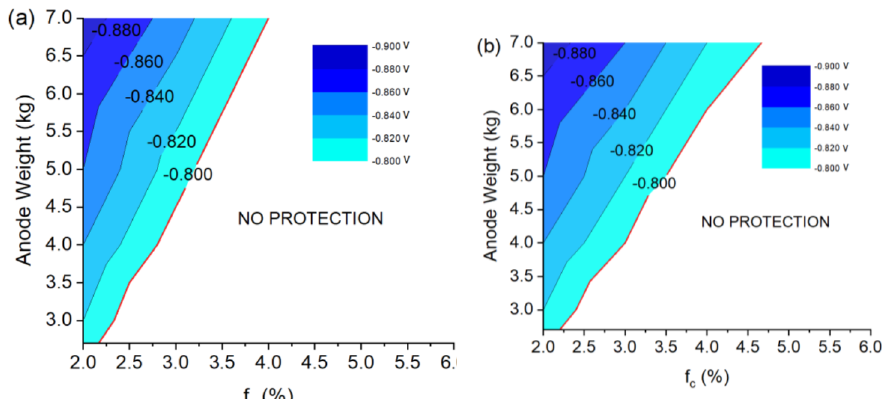
Figure 10. Minimum value of the protection overpotential as a function of breakdown factor and the anodic weight: ( a ) keeping constant the number of defects and increasing their size, ( b ) keeping constant the size of the defects and increasing their